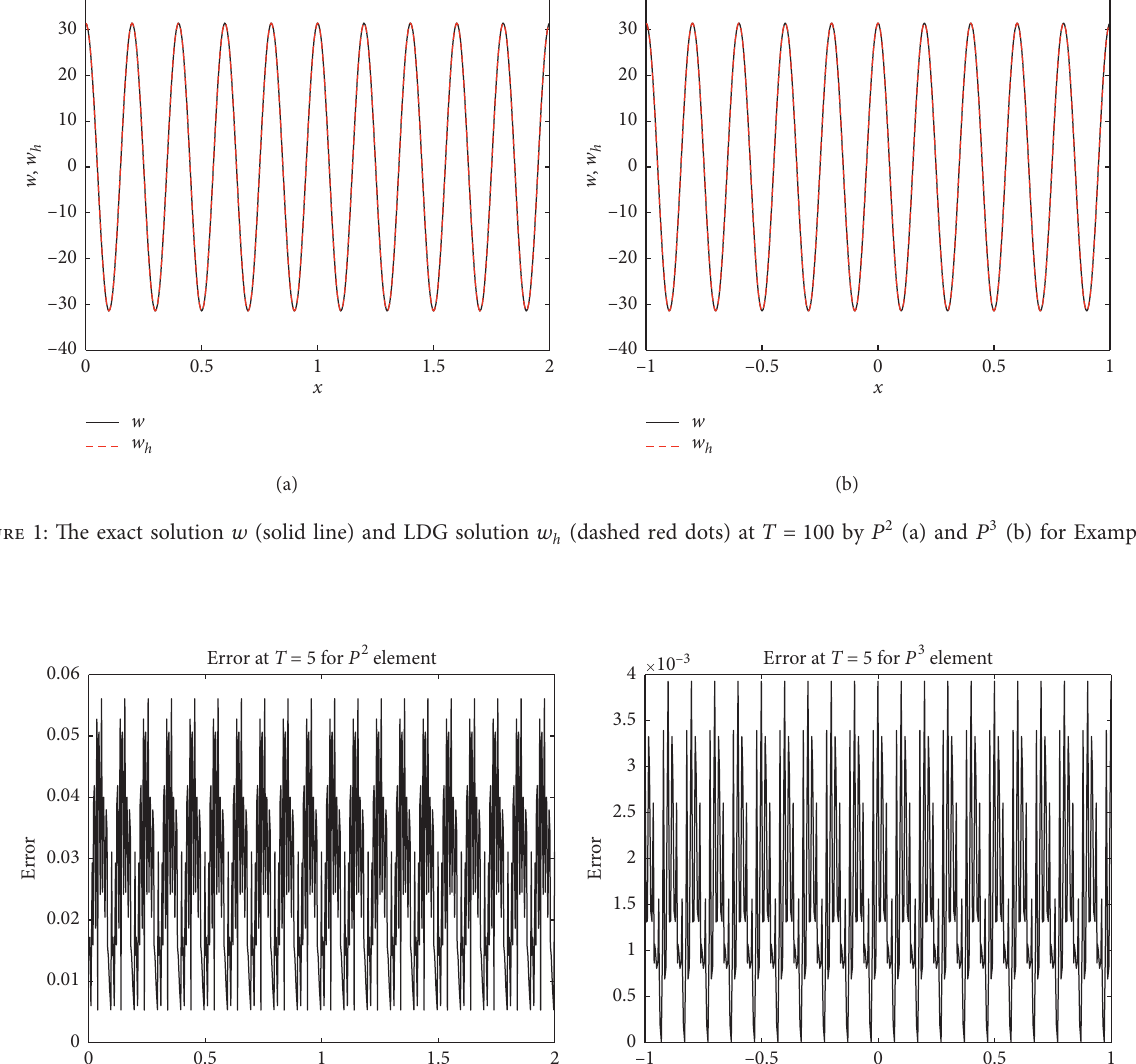
( x, t )‖ versus x at T � 5 by P 2 (a) and P 3 (b) for Example h